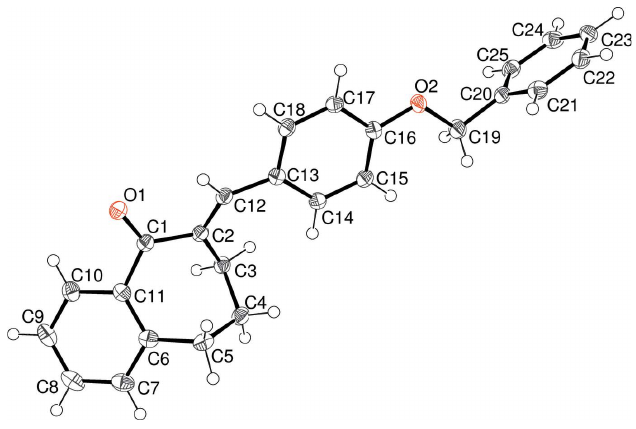
Figure 3 The molecular structure of (III), showing 50% probability displacement ellipsoids.